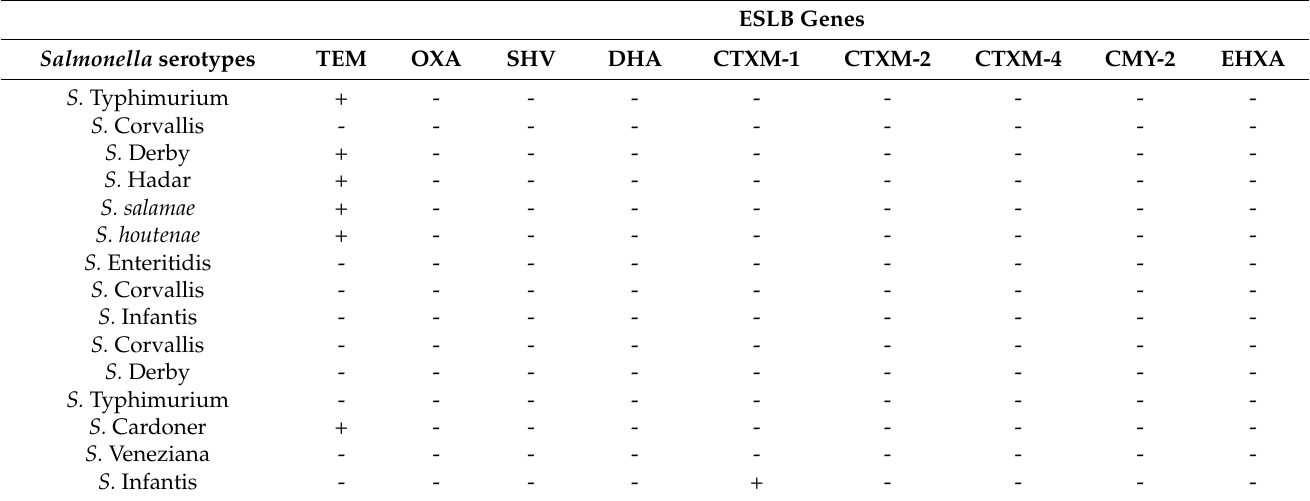
Table 3. ESBLs genotype of Salmonella strains.